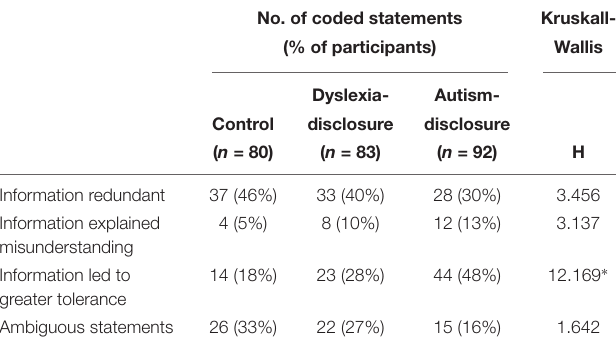
TABLE 4 | Frequency and distribution of coded statements from participants about the information received from the AC.